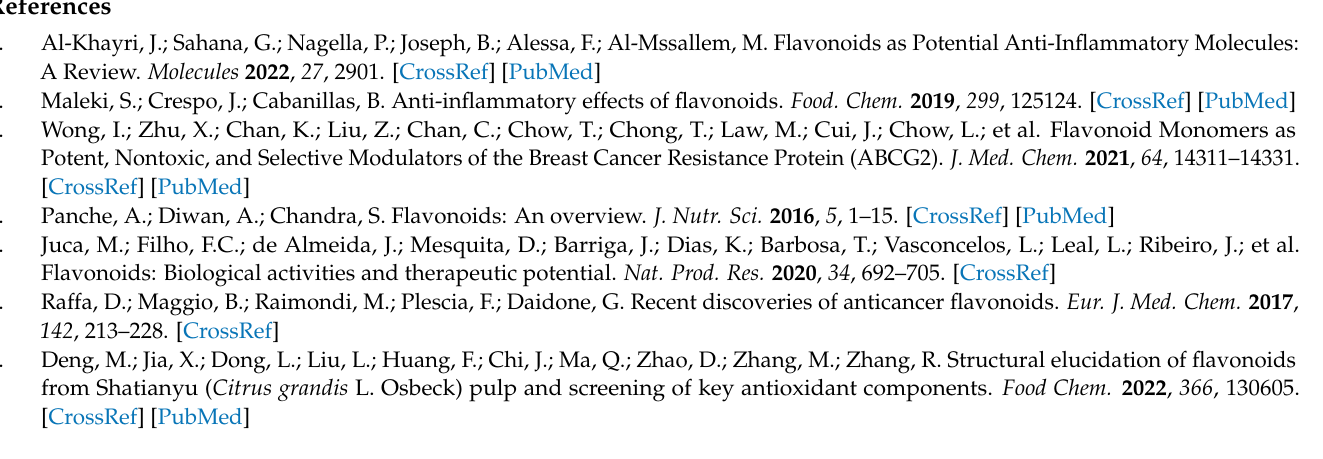
Spectral Data.; Table S2B: Comparison of 13 C NMR Spectral Data.; Table S3A: Comparison of 1 H NMR Spectral Data.; Table S3B: Comparison of 13 C NMR Spectral Data.; Table S4A: Comparison of 1 H NMR Spectral Data.; Table S4B: Comparison of 13 C NMR Spectral Data. Experimental procedures, and characterization data ( 1 H NMR, 13 C NMR, and HRMS) can be found in Supplementary